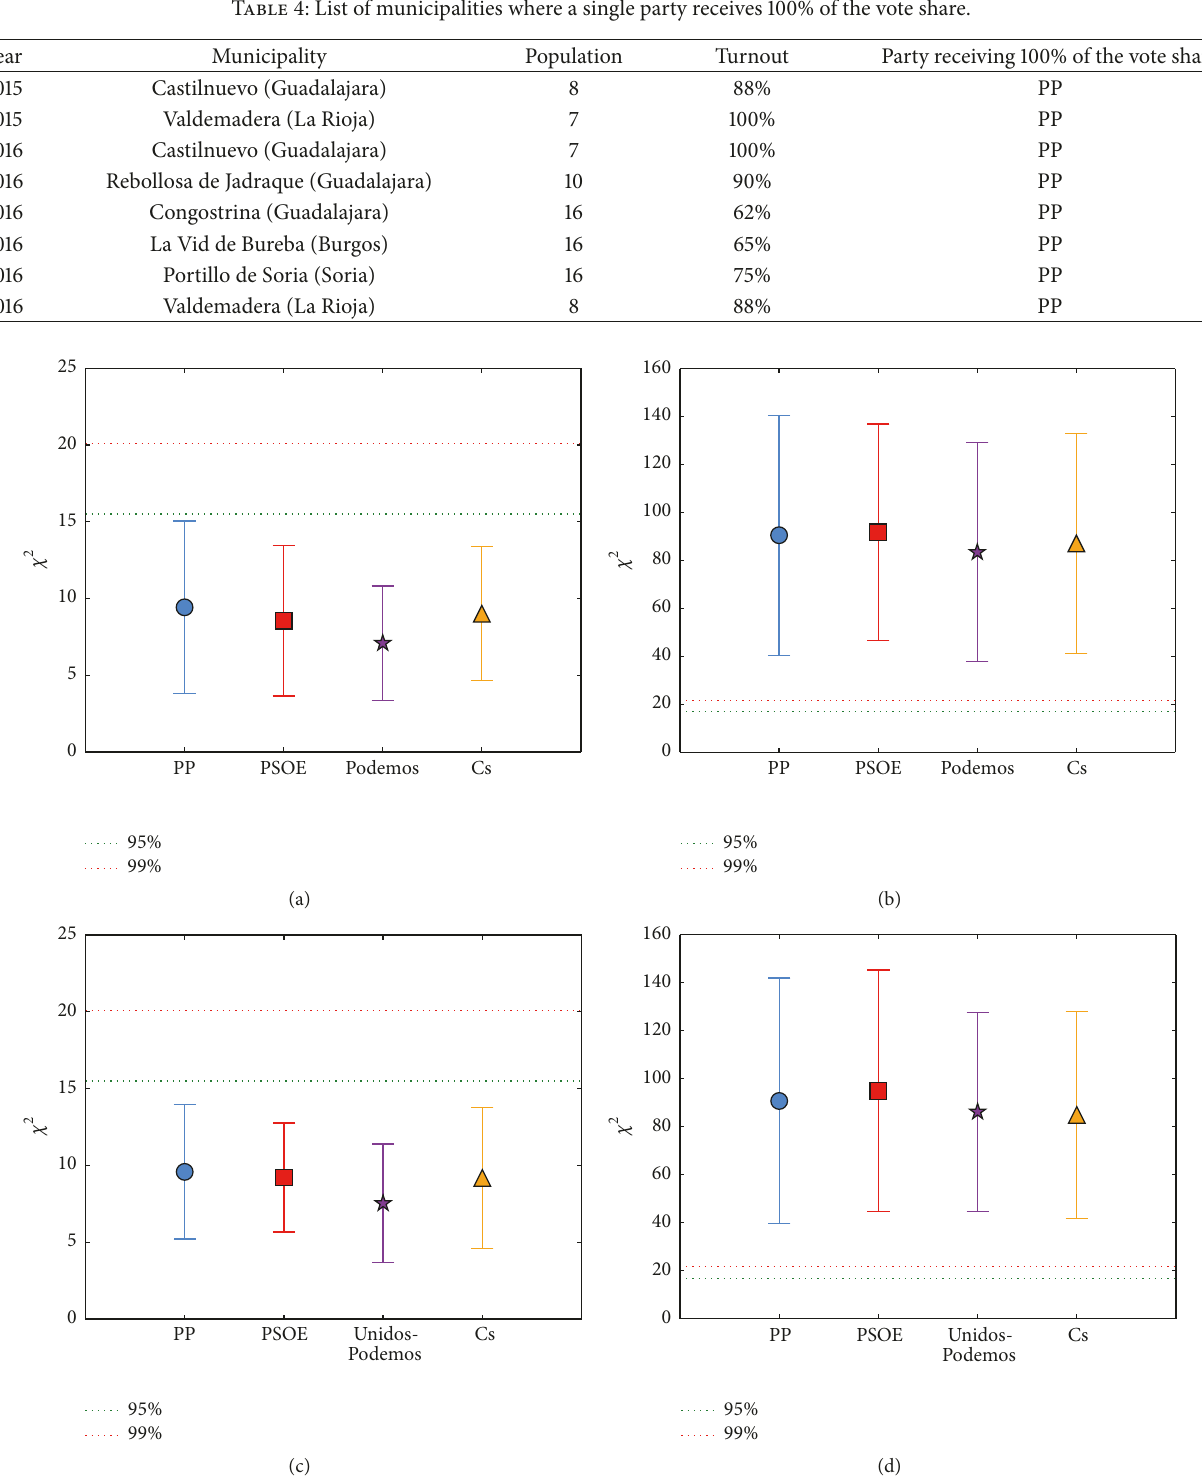
Figure 9: Summary of Pearson 𝜒 2 goodness of fit to 1BL (a, c) and 2BL (b, d) for 2015 (a, b) and 2016 (c, d) extracted from analysis of each individual precinct (each precinct contains a different number of municipalities and shows a precise distribution and an associated 𝜒 2 , so here we plot the mean ± standard deviation over all Spanish precincts (excluding Ceuta and Melilla, precincts with a single municipality)) for the main parties. In every case, the critical values for rejection at the 95 and 99% confidence level are shown. Interestingly, in the case of 1BL for a large majority, we accept conformance to Benford’s law, whereas in the case of 2BL for a large majority the null hypothesis is rejected. Results based on MAD suggest that neither 1BL nor 2BL is accepted (Figure